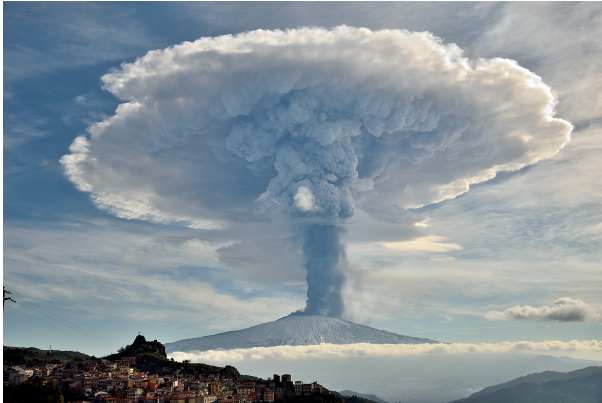
Figure 1. The 4 December 2015 paroxysm plume from Voragine crater at Mt. Etna, as viewed from Cesarò (Messina) at 09:27GMT. Photo by Giuseppe Famiani. The volcanic column rose vertically and then spread horizontally at the neutral buoyancy level in all the